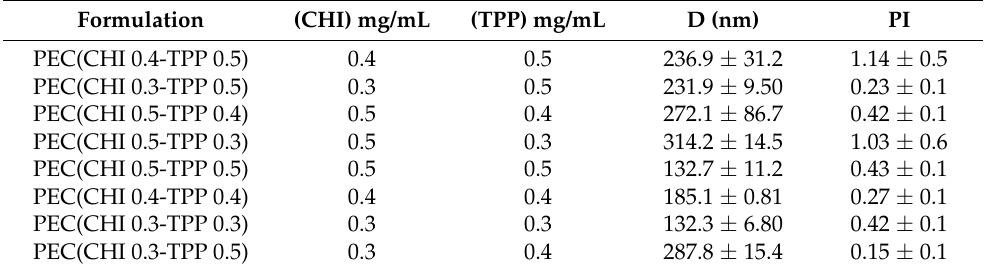
Table 1. Size and polydispersity index (PI) of different polyelectrolyte complex (PEC) formulations. All results are expressed as mean ± SD of at least three independent experiments. CHI: chitosan TPP: tripolyphosphate.